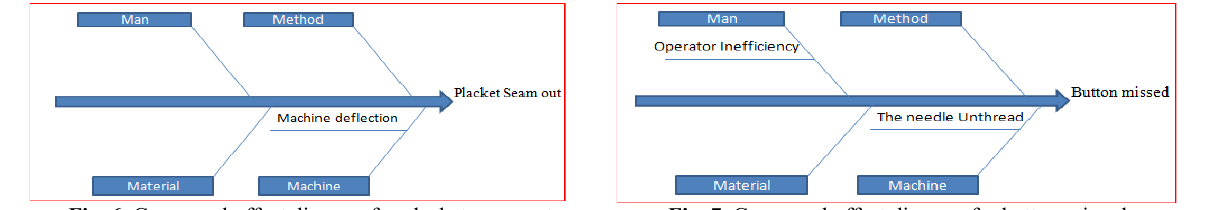
Fig. 6. Cause-and-effect diagram for placket seam out Fig. 7. Cause-and-effect diagram for button missed